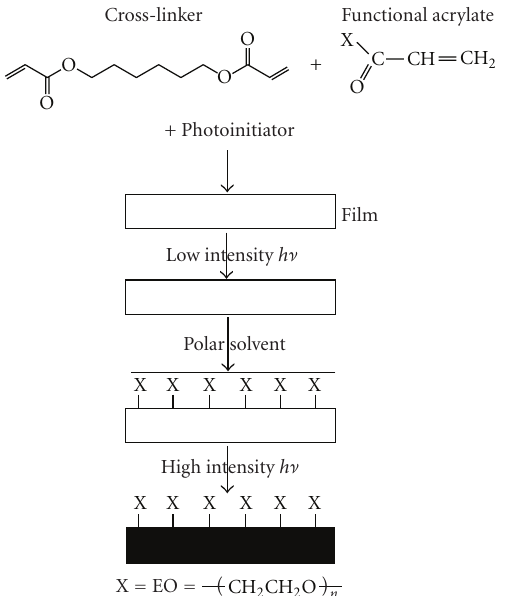
Figure 1: Two-step procedure for the photo-curing of a PEG- acrylate layer for enhancement of the surface density of EO groups